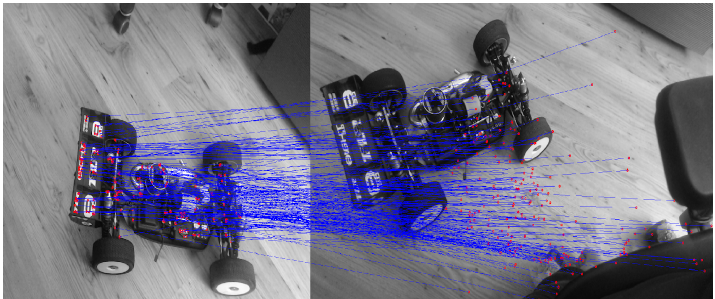
Figure 12. No initial